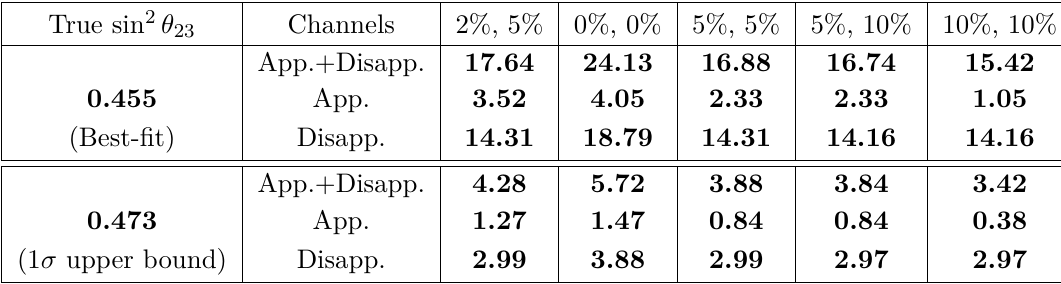
Table 3 . Impact of systematics uncertainties on the determination of non-maximal sin 2 θ 23 . We show results for sin 2 θ 23 (true) = 0.455 (current best-fit) and sin 2 θ 23 (true) = 0.473 (current 1 σ upper bound) assuming true NMO and δ CP (true) = 223 ◦ with 7 years of exposure equally shared in ν and ¯ ν modes. We estimate the sensitivity for different choices of normalization uncertainties on appearance and disappearance events [(2%, 5%), (0%, 0%), (5%, 5%), (5%, 10%), and (10%, 10%)], where (2%, 5%) is the benchmark choice [93]. We keep the normalization uncertainties on various backgrounds fixed at their default values as given in ref. [93]. Results are given for appearance channel, disappearance channel, and their combination. In the fit, we marginalize over the current 3 σ range of ∆ m 2 and δ CP , keeping rest of the oscillation parameters 31 fixed at their present best-fit values as shown in table